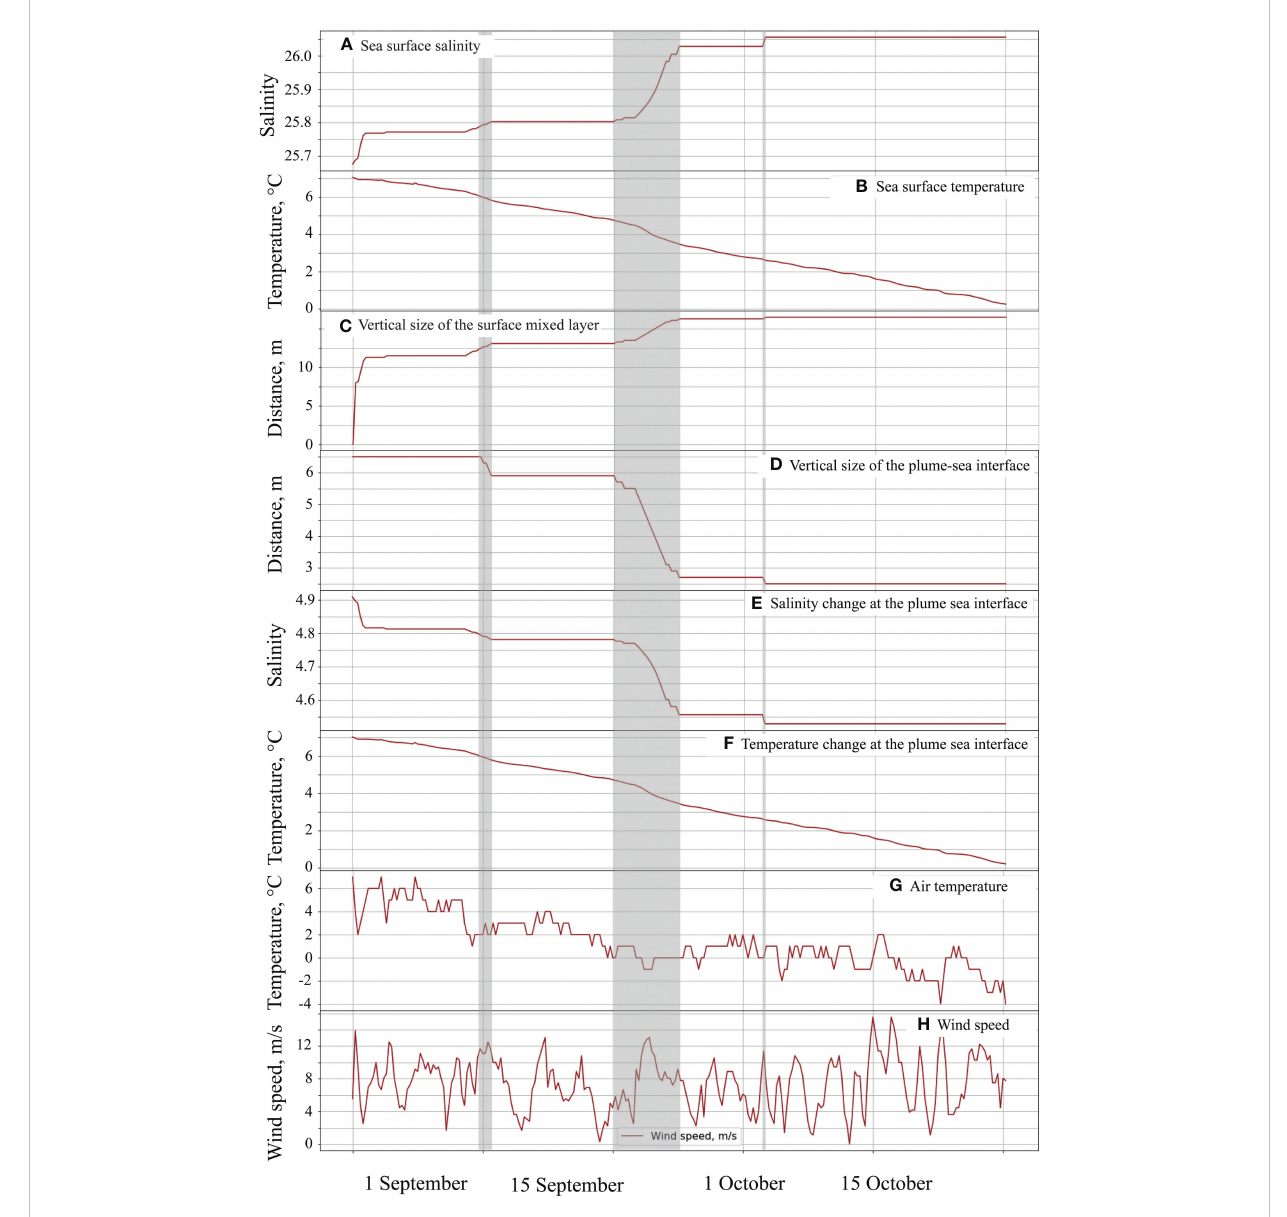
FIGURE 12 Surface salinity (A) and temperature (B) , vertical sizes of the surface mixed layer (C) and the plume-sea interface (D) , temperature (E) and salinity (F) changes at plume-sea interface, air temperature (G) and wind speed (H) during the period of numerical modeling of vertical structure of the eastern part of the Ob-Yenisei plume from the middle of August till late October. Gray bands indicate periods of intense